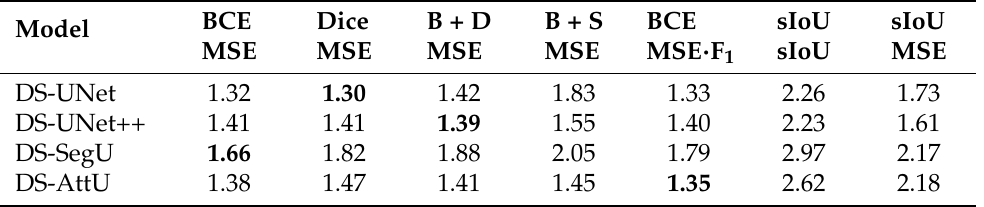
Table 2. Performances in terms of rMSE. Results on burnt-areas only, with different loss functions, for the final regression backbone. The best loss configuration for each model is highlighted in bold. Model BCE MSE